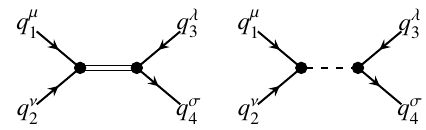
Figure 3. Two of the diagrams contributing to to HLbL tensor in HS model. The diagram on the left contains the 5D axial Green function and accounts for the contribution od the massive axial- vector resonances. On the right is the usual one-pion exchange diagram. Two other couples of diagrams are obtained by crossing operations C 13 and C 14